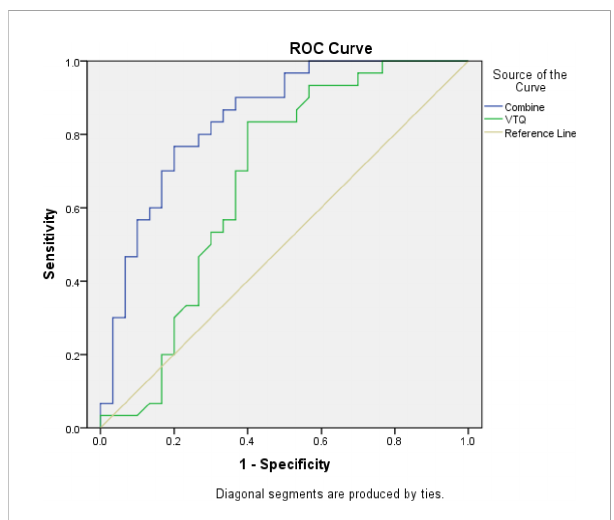
FIGURE 4 The area under the ROC curve (AUC) for the combined use of CXCL13 and VTQ was 0.842 (0.74, 0.94), which was signi fi cantly higher than that of VTQ alone (AUC = 0.674, 95% CI: 0.53, 0.82; P < 0.05), indicating a statistically signi fi cant difference between the two